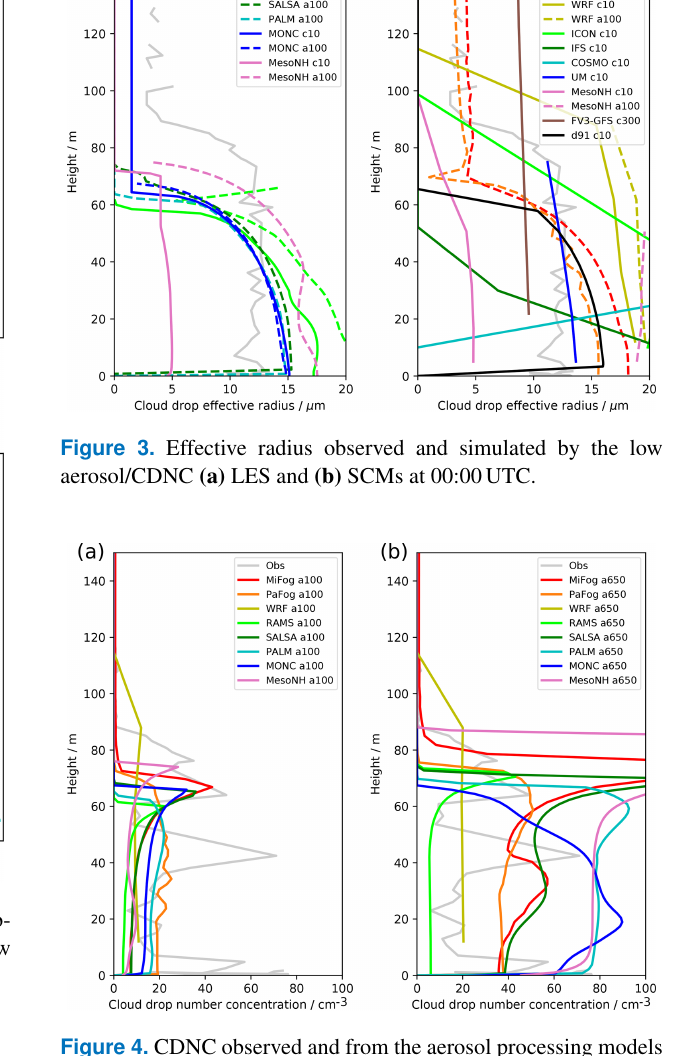
Figure 4. CDNC observed and from the aerosol processing models at 00:00UTC for (a) low aerosol and (b) high